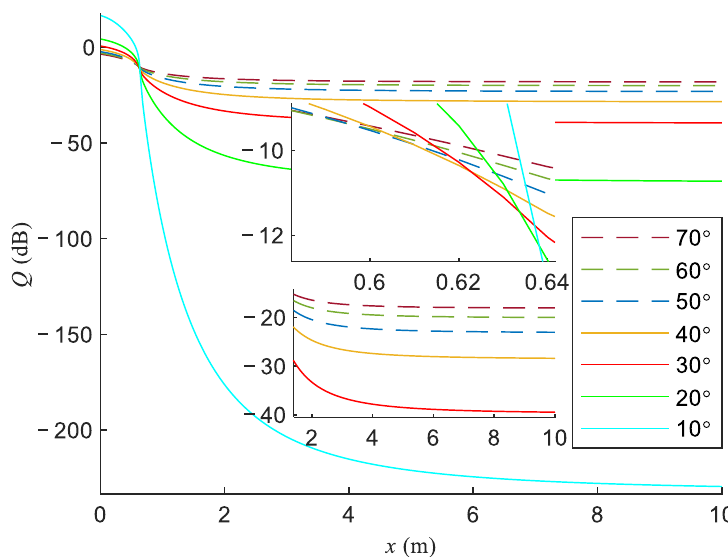
Figure 7. Calculation results of the relationship between the Q and x in the situation of a corner between two infinitely long walls.